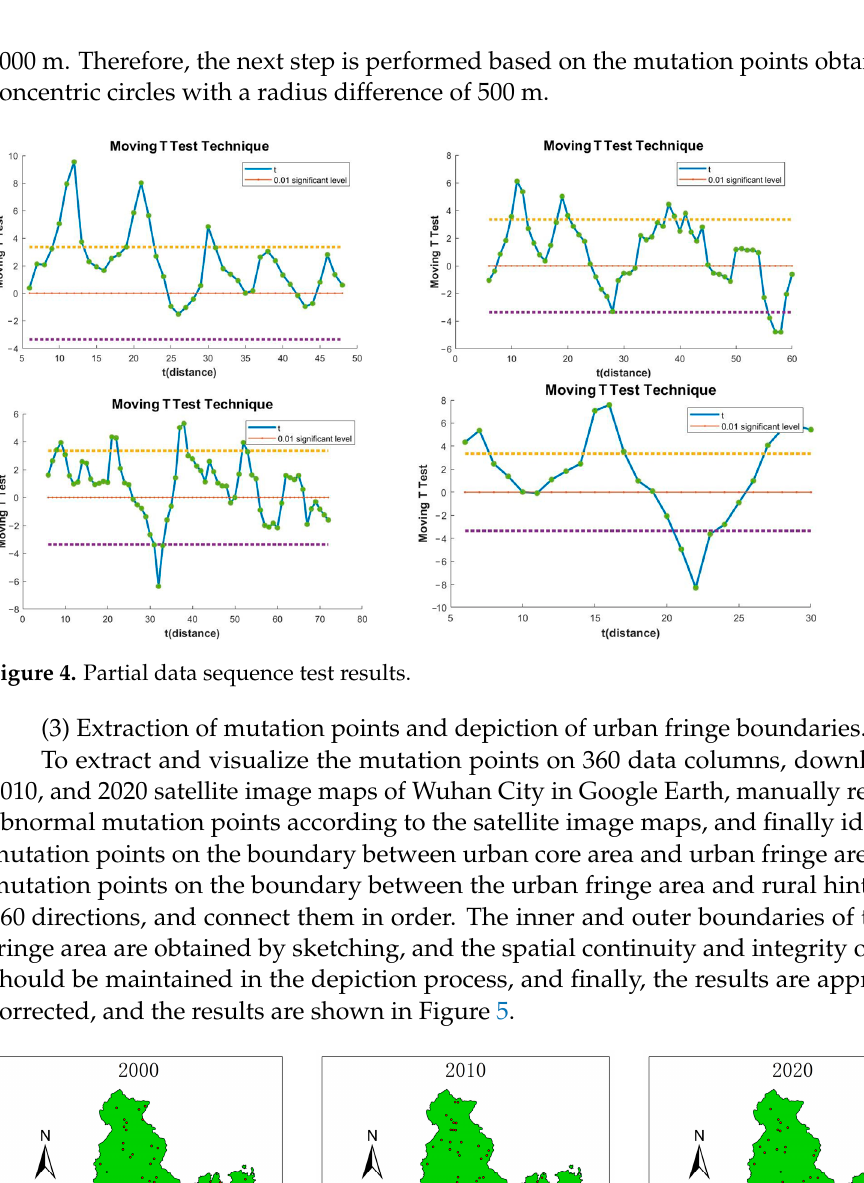
9 of 30 Figure 3. Spatial sampling point design process.